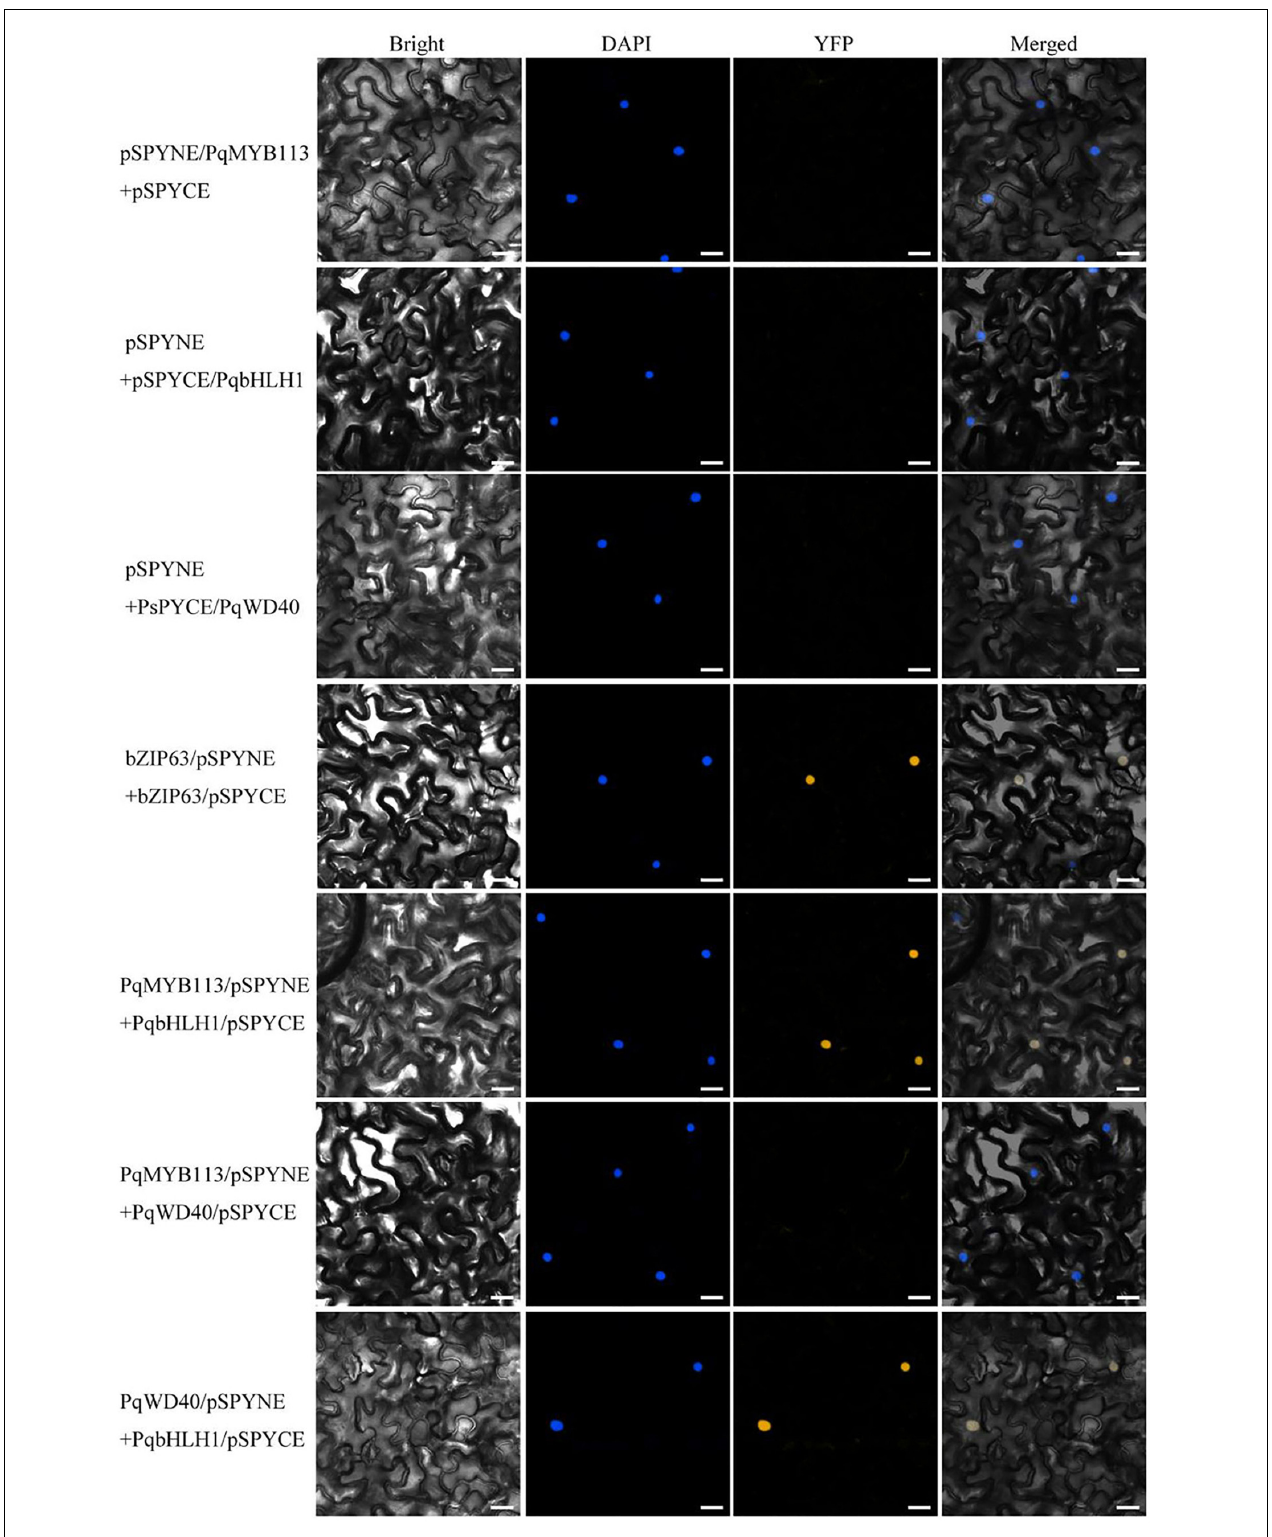
FIGURE 9 | Bimolecular fluorescence complementation in Nicotiana benthamiana leaves. Bright, field images show the complete epidermal cell profile in bright-field view; YFP, fluorescence of YFP; DAPI, nuclear staining; “Merge” is merged with chloroplast autofluorescence, YFP fluorescence and bright field images. Bars = 25 µ